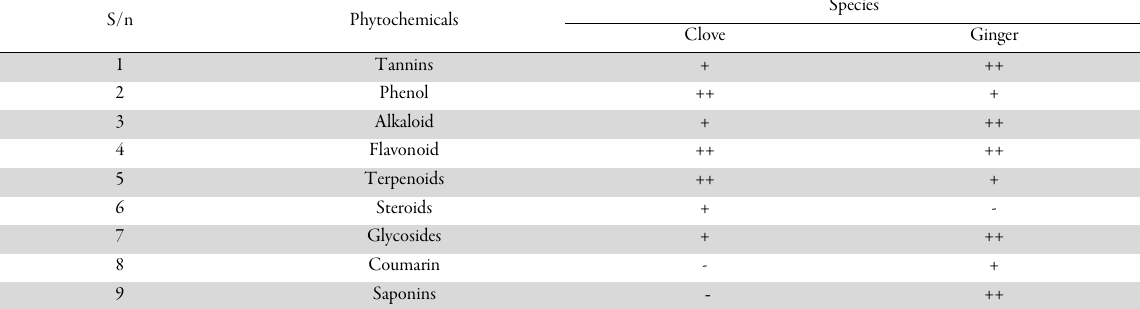
Table 2. The phytochemicals present in clove and ginger